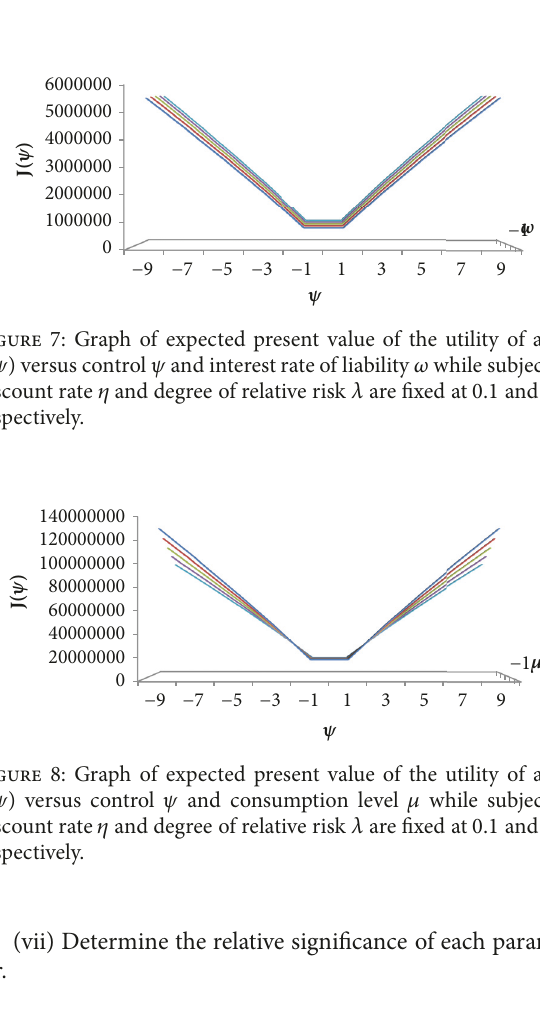
Figure 3: Graph of expected present value of the utility of asset 𝐽(𝜓) versus control 𝜓 and degree of relative risk 𝜆 while subjective discount rate 𝜂 is fixed at 0.9 .